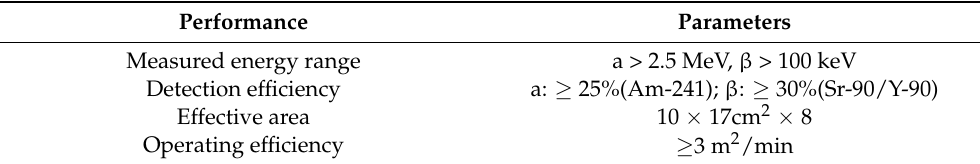
Figure 2. Surface-contamination monitor’s construction diagram.